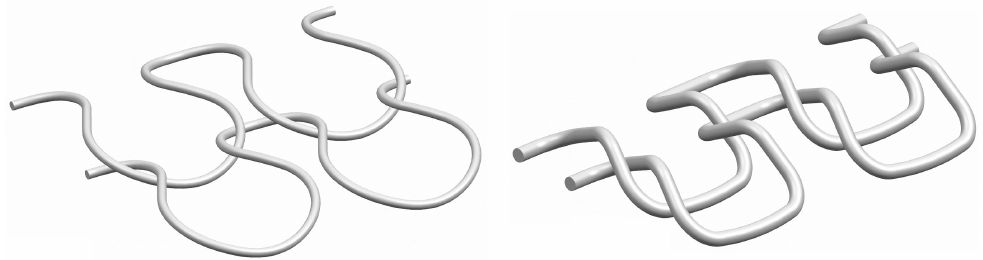
Figure 1. Wire meshes under investigation. Left : type A, right : type B. A total of four stitches distributed in two rows are shown for each